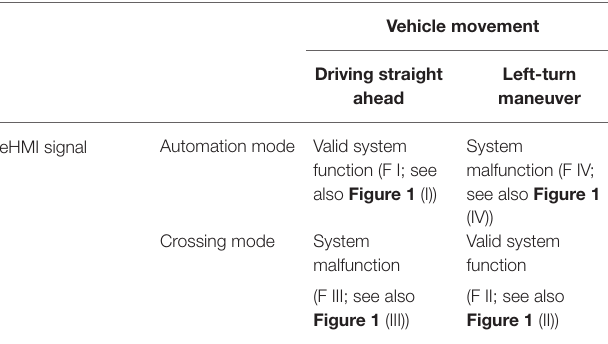
TABLE 1 | Overview of the valid and invalid eHMI functions resulting from the vehicle’s movements as implicit communication signals and the eHMI